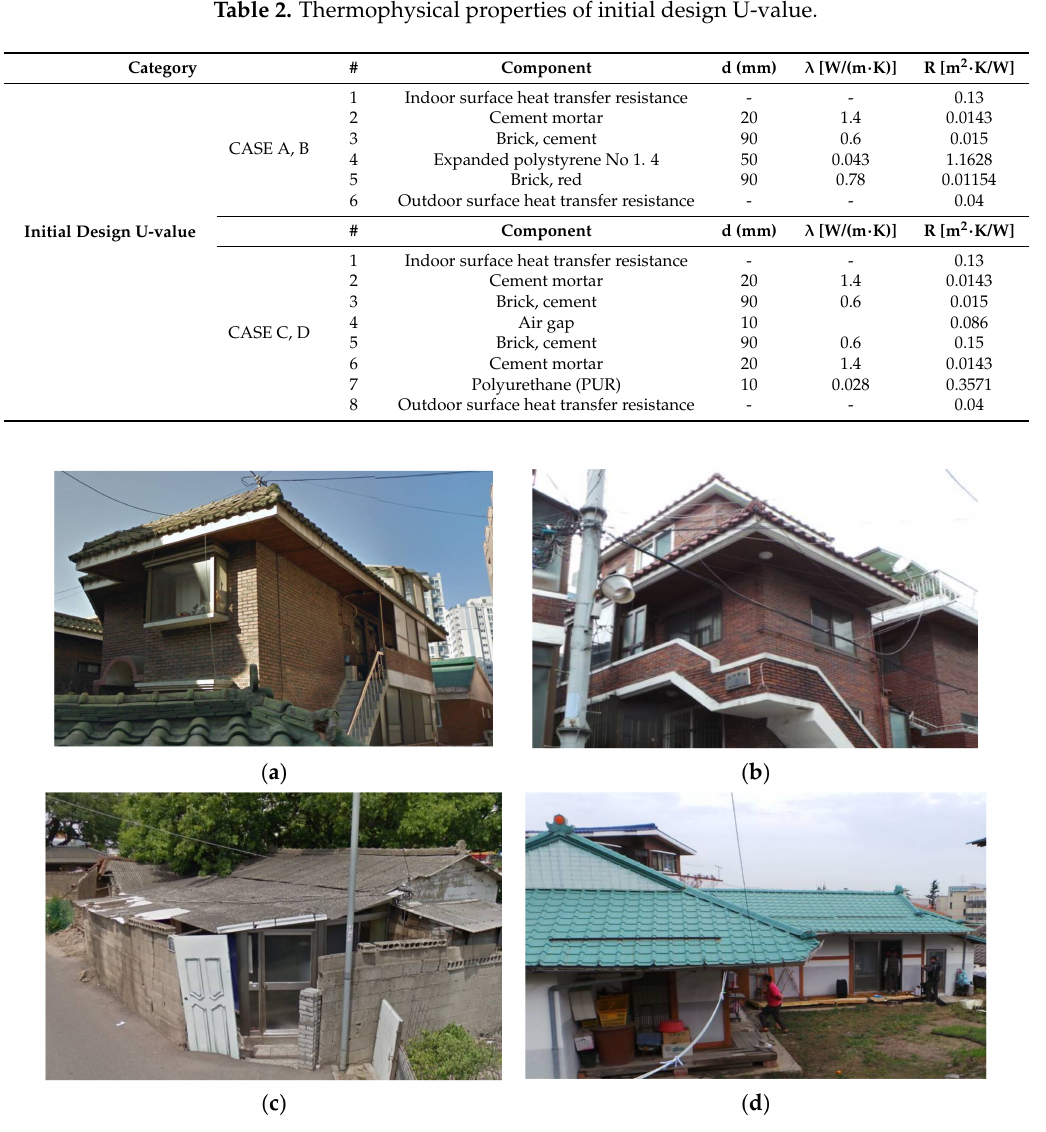
Table 2. Thermophysical properties of initial design U-value.